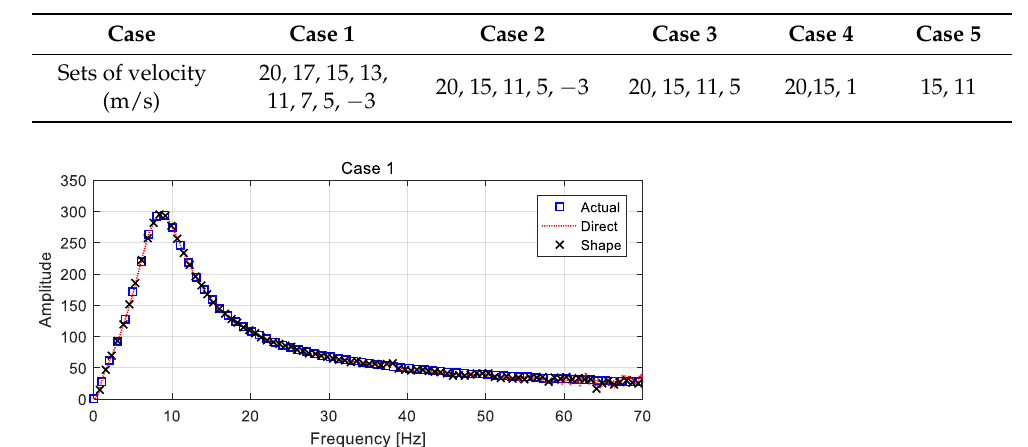
Figure 12. Comparison of the amplitudes of the vehicle acceleration frequency response function (FRF) along DOF u 1 in Case 1.